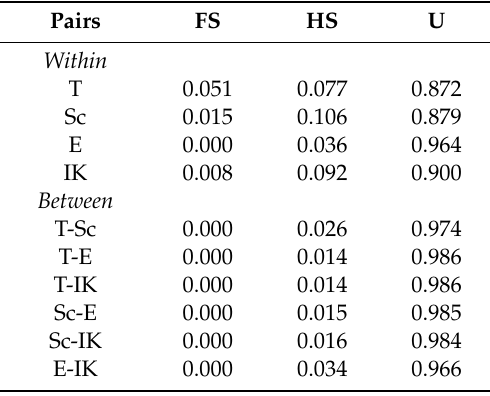
Table 3. Percentage of relationships within and between sampling sites estimated by ML-RELATE (1 = 100%). FS: full siblings, HS: half siblings, U: unrelated. Other relationships (e.g., parent–offspring) were not detected.